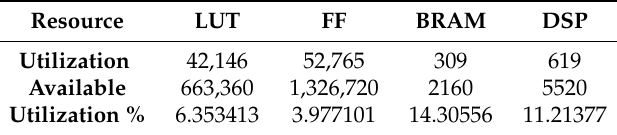
Table 9. Resource utilization.